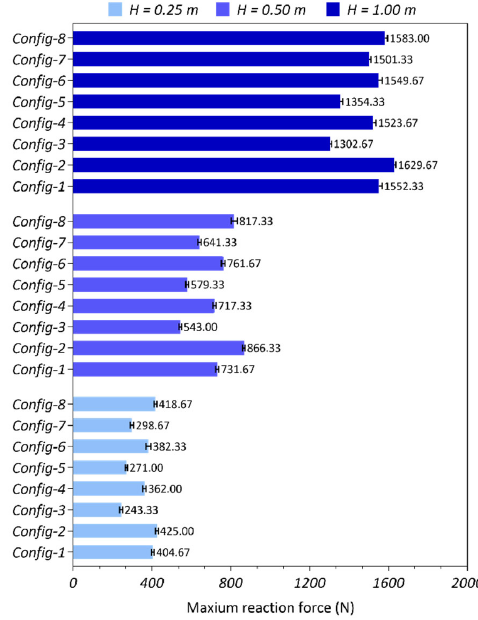
Figure 4. Maximum reaction forces for configurations.